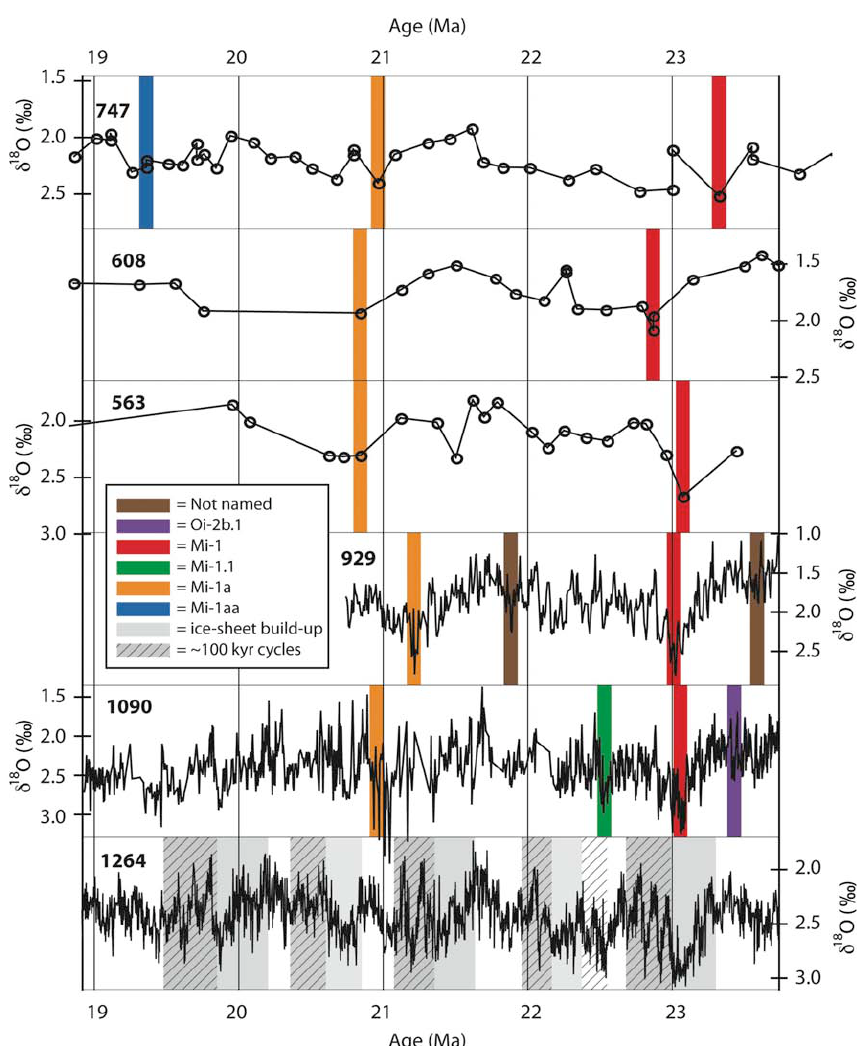
Fig. 8. Transcription of latest Oligocene and early Miocene Oi- and Mi-naming scheme through time. Comparison between isotope records from the Kerguelen Plateau Site 747 and the North Atlantic Sites 563 and 608 (Wright et al., 1992; Wright and Miller, 1992) with Site 1264 (this study). Ages of Sites 563, 608 (Berggren et al., 1995) and magnetostratigraphy of Site 747 (Oslick et al., 1994) have been recalculated to the ATNTS2004 (Lourens et al., 2004). Site 929 (Zachos et al., 1997, 2001b; Paul et al., 2000) and Site 1090 (Billups et al., 2002, 2004) are plotted on the Walvis Ridge Site 1264 age model. The Oi- and Mi-zones or episodes were first described at Sites 563, 608 and 747. These names were then (sometimes erroneously) transposed to Sites 929 and 1090. The ∼ 100kyr dominated intervals described in this study shed new light on the major zones/episodes in the early Miocene and are close within the age estimates of the previously described Mi-1, Mi-1a and Mi-1aa zones or episodes. Nevertheless we support a 400kyr number-based naming scheme (e.g. Wade and P¨alike,